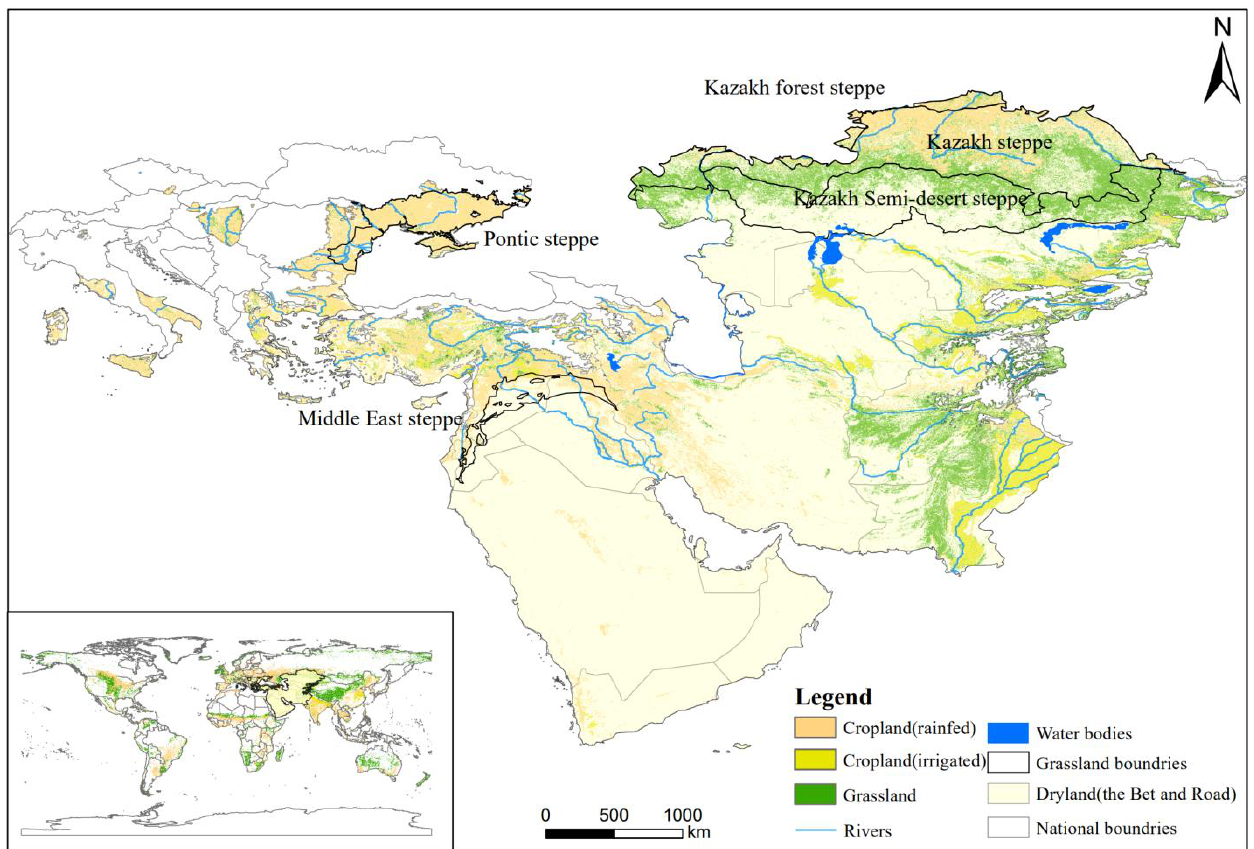
Figure 1. Grassland distribution along the Central Route's "Belt and Road" countries. The map is based on the standard map No.GS(2021)5453 downloaded from the map technology review center of Ministry of natural resources, the standard map is not